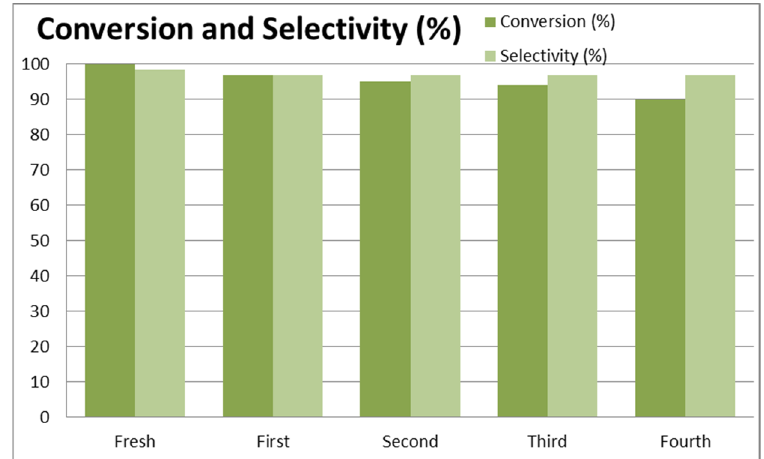
Figure 1. Cycling performing of MK10 in synthesis of 1-benzyl-2-phenyl-benzimidazole using the optimal reaction conditions.